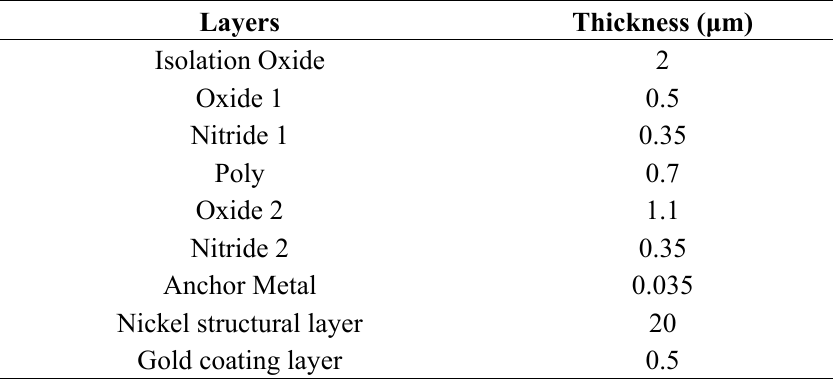
Table 1. Structural parameters of the